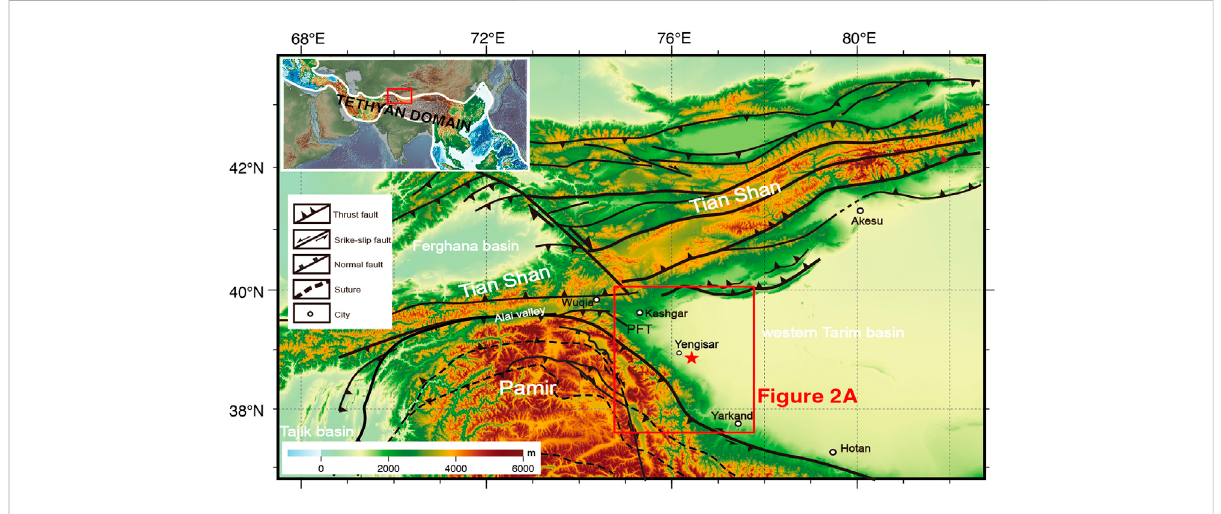
FIGURE 1 Simpli fi ed tectonic map of the western Tarim Basin and its surrounding orogens (after Xu et al., 2011; Li et al.,